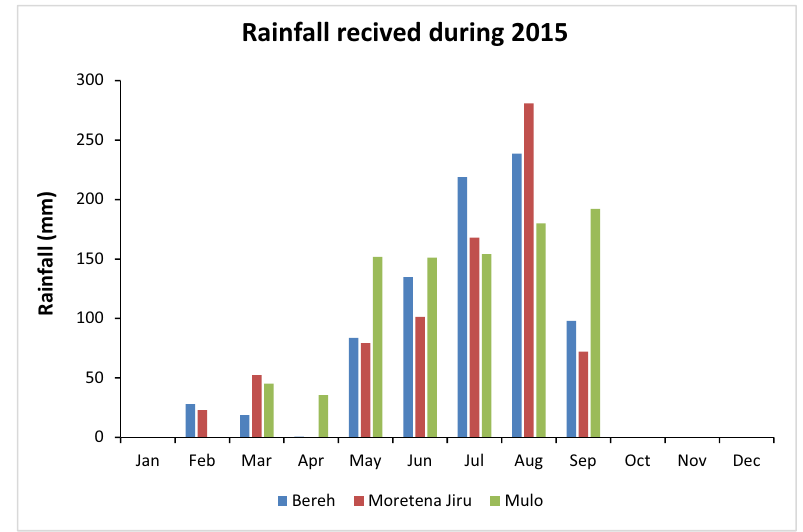
Figure 2: Monthly rainfall Bereh, Moretina Jiru, and Mulo trial sites in 2015 ( Bereh and Sululta share the same meteorological station and have the same weather data )